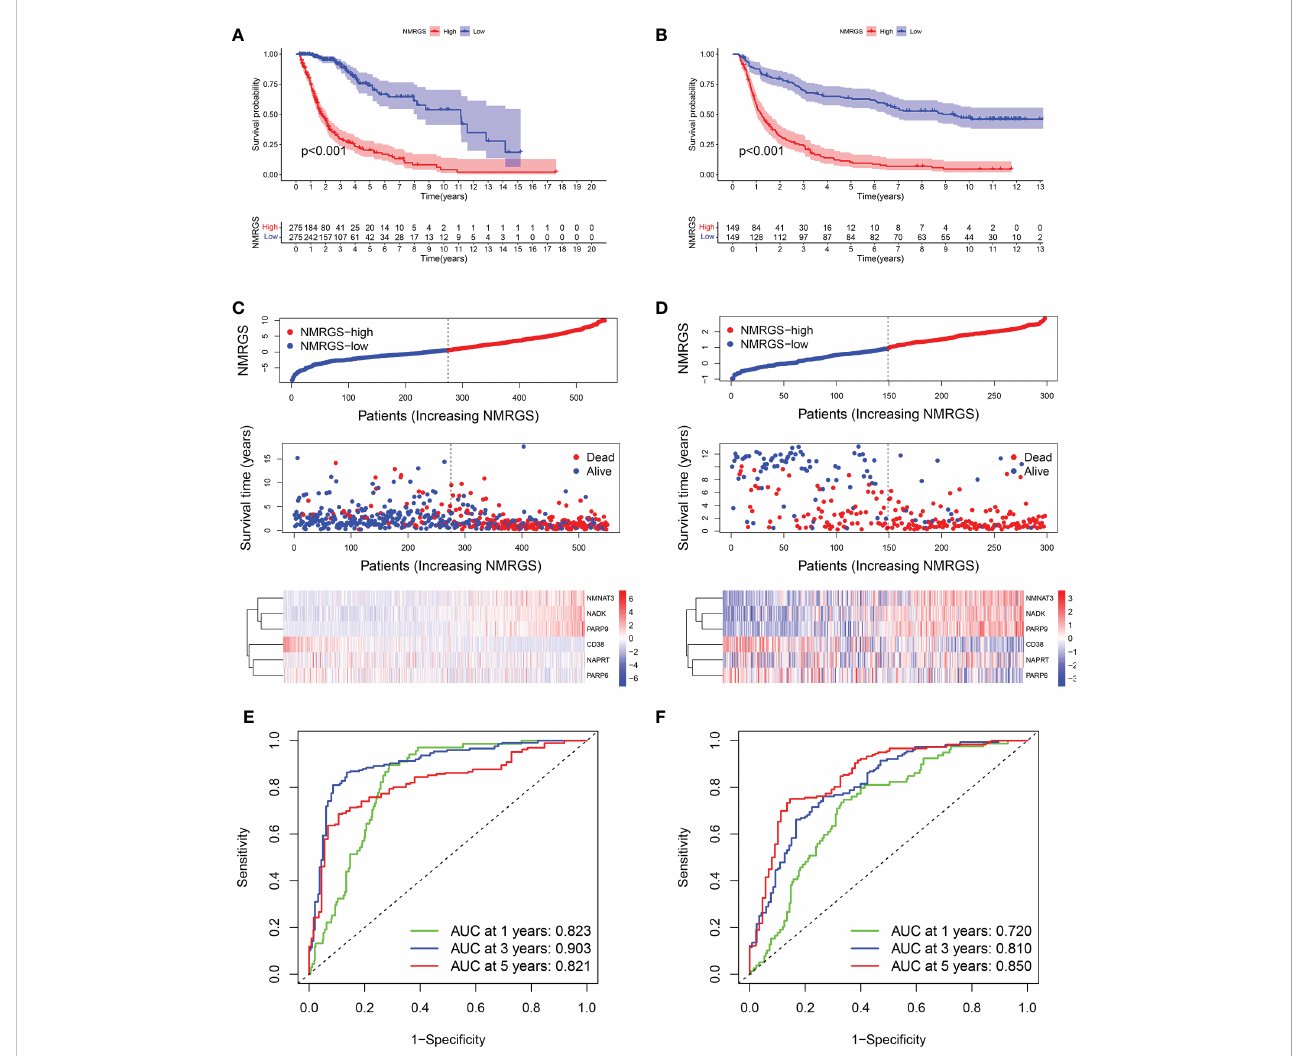
FIGURE 4 Validation of the NMRGS in TCGA and CGGA325 cohorts. (A, B) Kaplan-Meier analysis for survival in TCGA and CGGA325 cohorts. (C, D) Distribution plot of NMRGS score and survival status of glioma patients in TCGA and CGGA325 cohorts. (E, F) ROC curve analyses of NMRGS in predicting 1-, 3-, and 5- year overall survival in TCGA and CGGA325